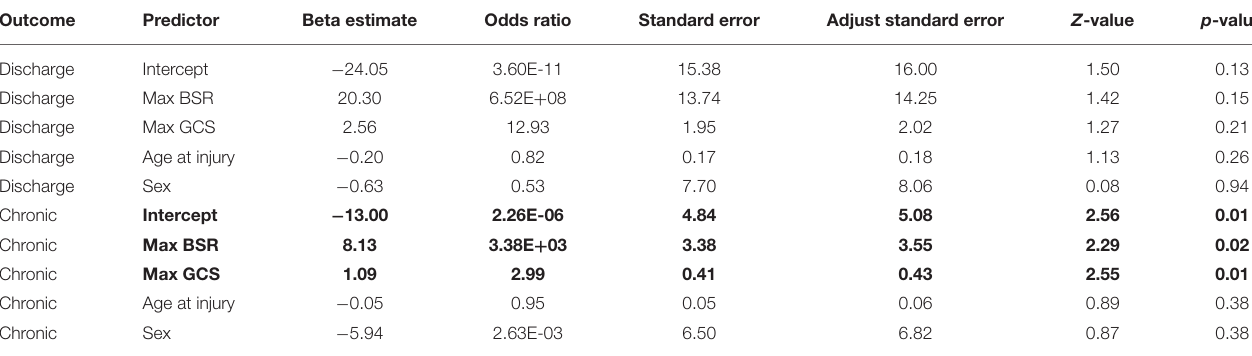
TABLE 3 | Model averaged